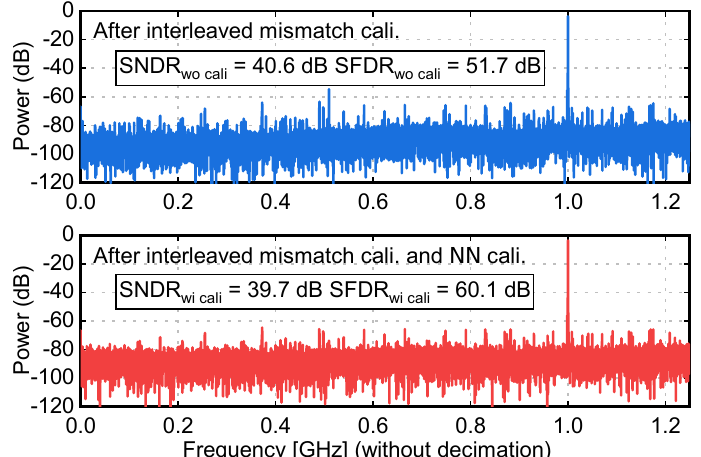
Figure 13. Measured output spectrum for a high-frequency input with and without NNC @ 2.5 GS/s after channel mismatch calibrated.